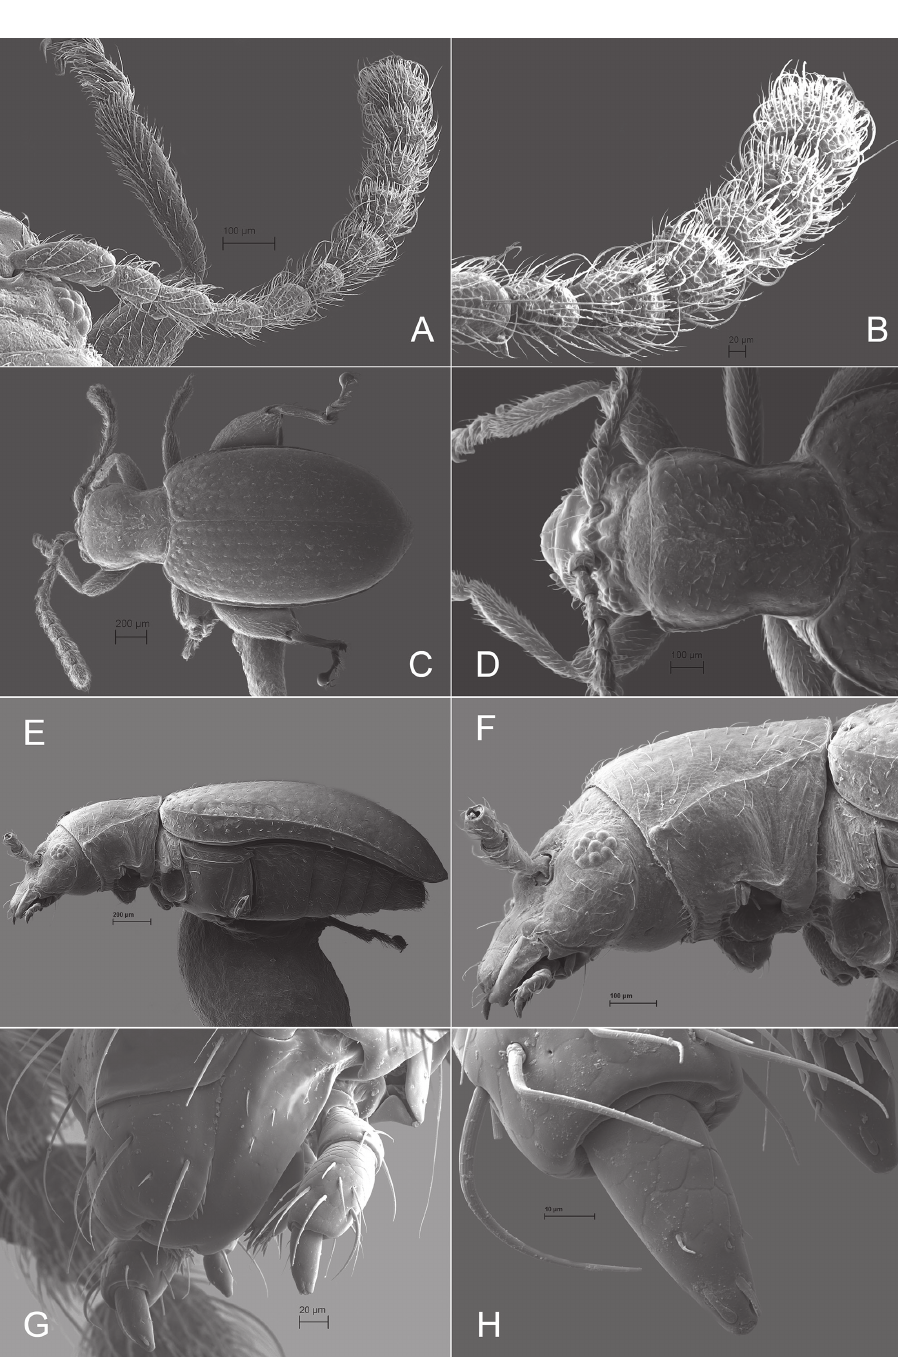
Figure 25. Andersonoplatus microoculus . A Antenna B Seven apical antennomeres C Habitus dorsal D Pronotum in dorsal view E Habitus lateral F Head and pronotum in lateral view G Mouth parts in lateral view H Last maxillary